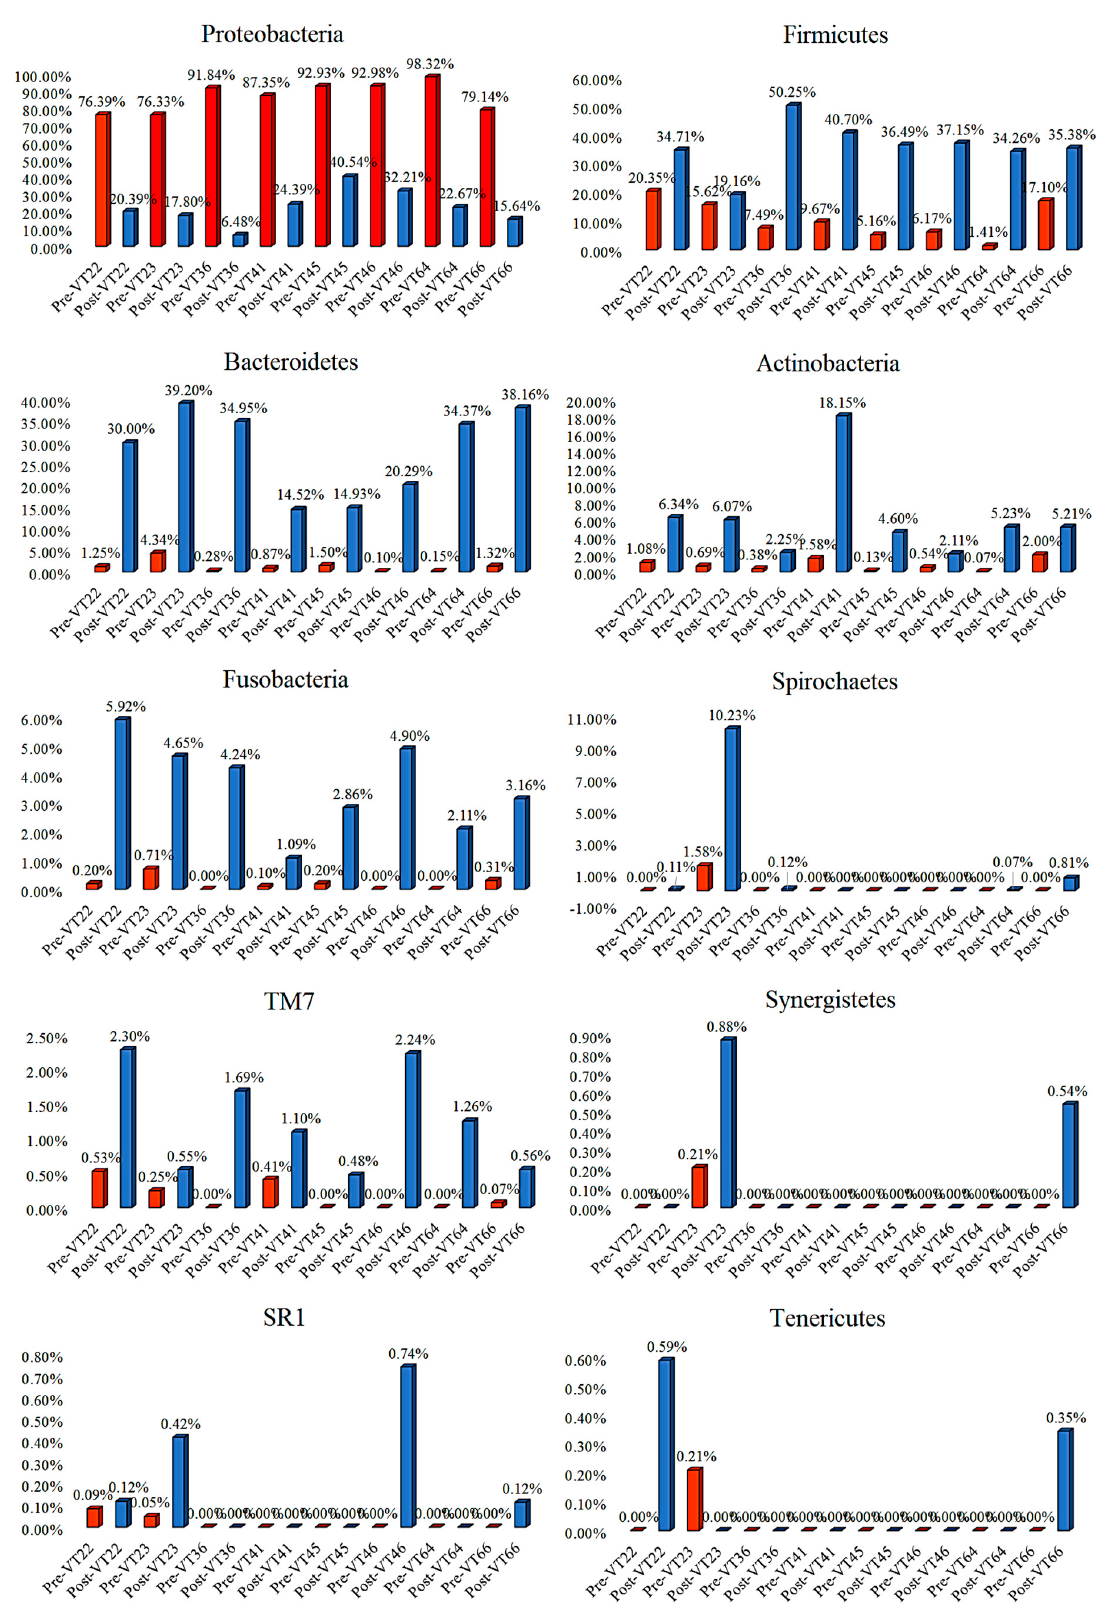
Figure 4. The abundant phyla of the G1 (mouthwash formulation I) samples were compared before and after mouthwash to identify the formulation’s efficacy. Red and blue bars indicate the pre-and post-treatment samples, respectively.